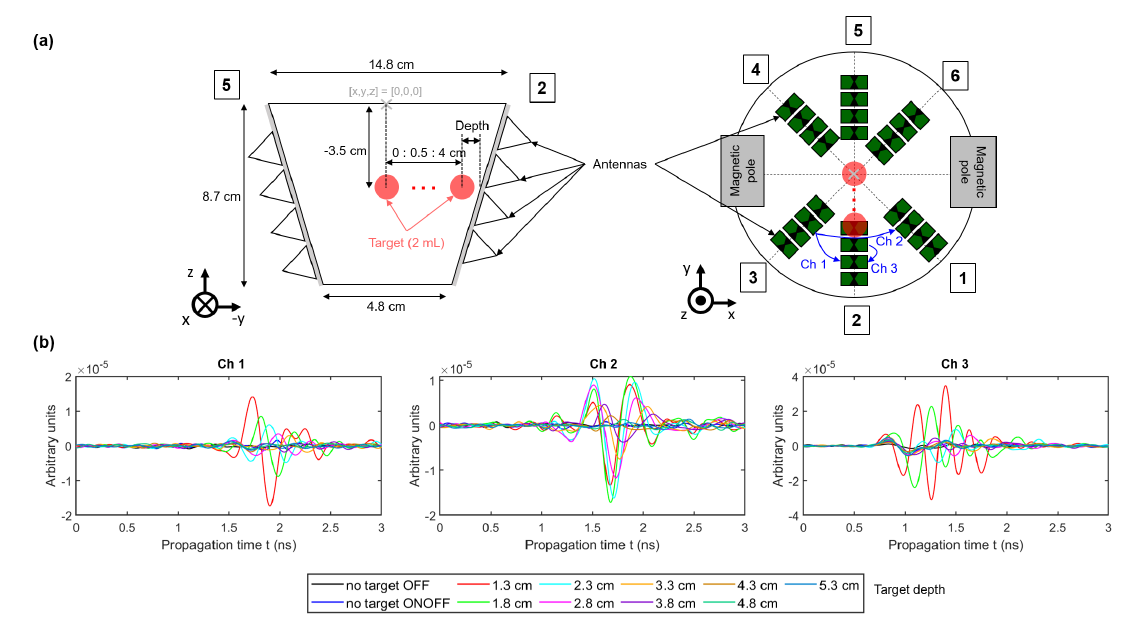
Figure 8. ( a ) Schematic of the measurement setup and the different target positions. ( b ) Differential IRFs for different channels with the depth-dependent MNP response. The depth is related to the distance between the target and the wall of the examination mold.